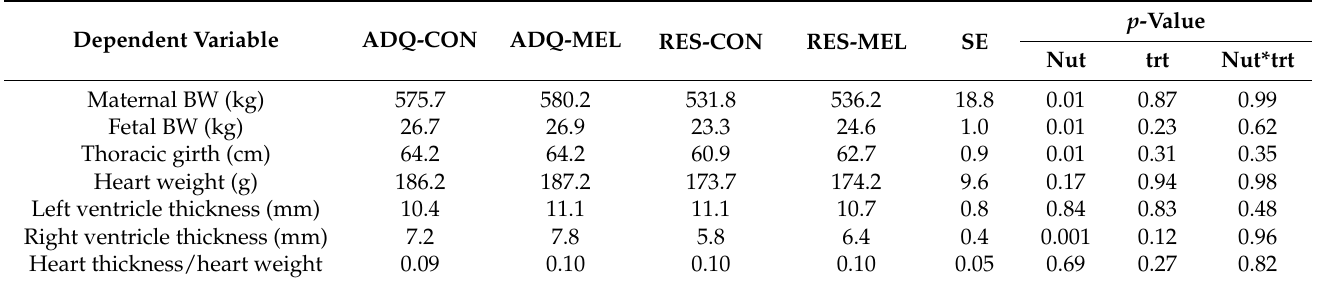
Table 1. Maternal body weight and fetal growth parameters from day 240 of gestation. Data adapted from Contreras-Correa et al. [20].